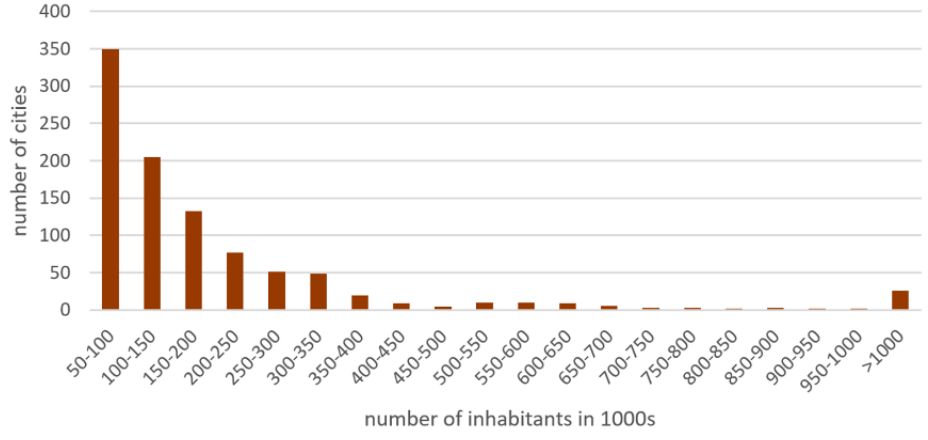
Figure 1. Distribution of cities according to population size in the European Union (EU) [26].